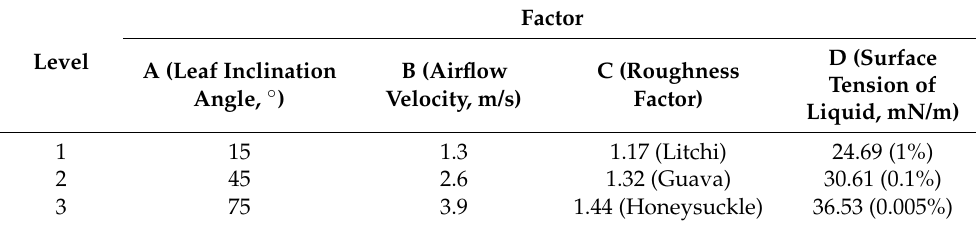
Table 5. Orthogonal test factors and levels.